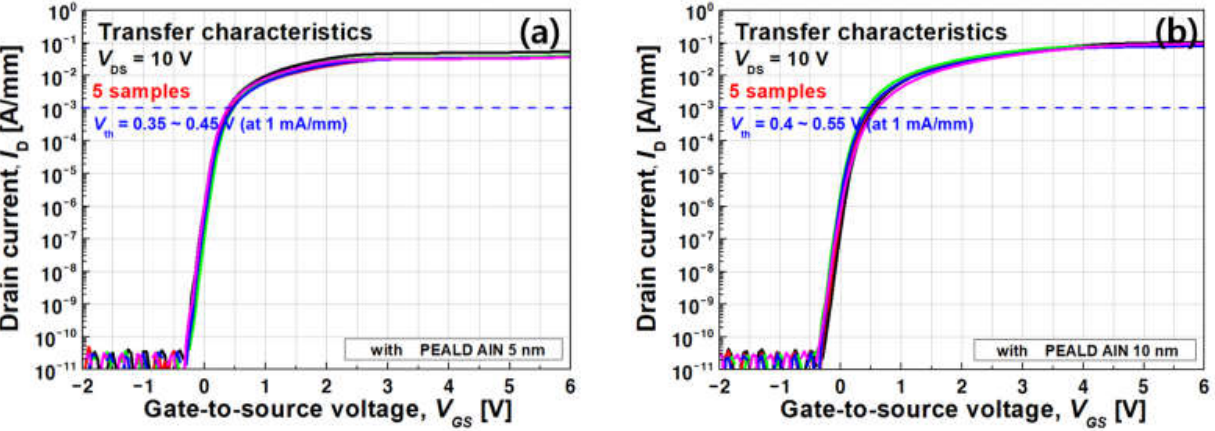
Figure 9. Threshold voltage characteristics obtained from multiple devices in samples with ( a ) 5 nm and ( b ) 10 nm AlN layers.